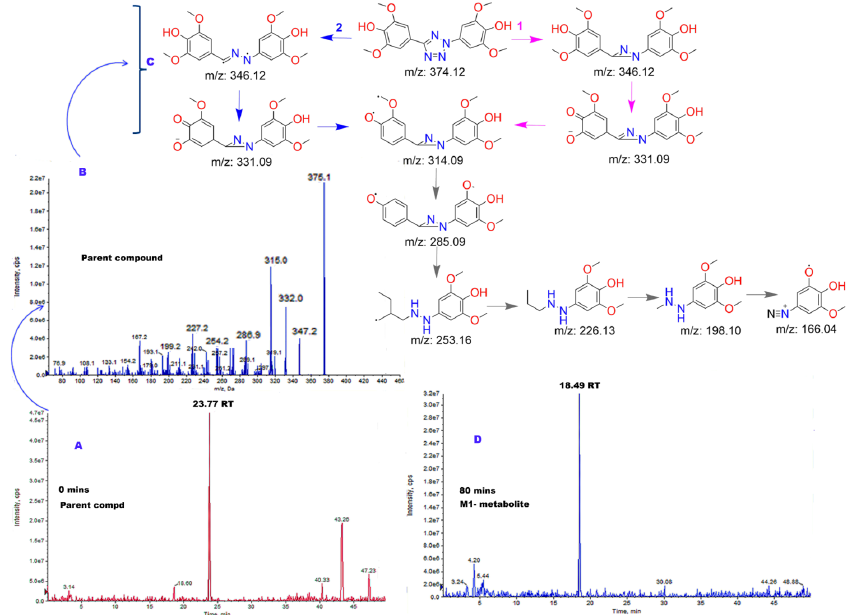
Figure 9. MetID studies of 223-2 incubated in hepatocytes until 80 min. ( A ) Representative chro- matogram at 0 min of incubated TbB ligand 223-2 at room temperature. The peak of the parent compound (223-2) is observed at RT of 23.77 min. ( B ) Enhanced product ion (EPI) spectrum with the full range of product ions of 223-2 ligand. ( C ) Schematic representation of the proposed cleavage resulting in the fragmentation of the TbB ligand 223-2 based on the EPI spectra shown in ( B ). ( D ) Representative chromatogram of incubated TbB ligand 223-2 at room temperature highlighting the formation of M1 metabolite at RT of 18.49 min due to metabolism of 223-2 ligand at 80